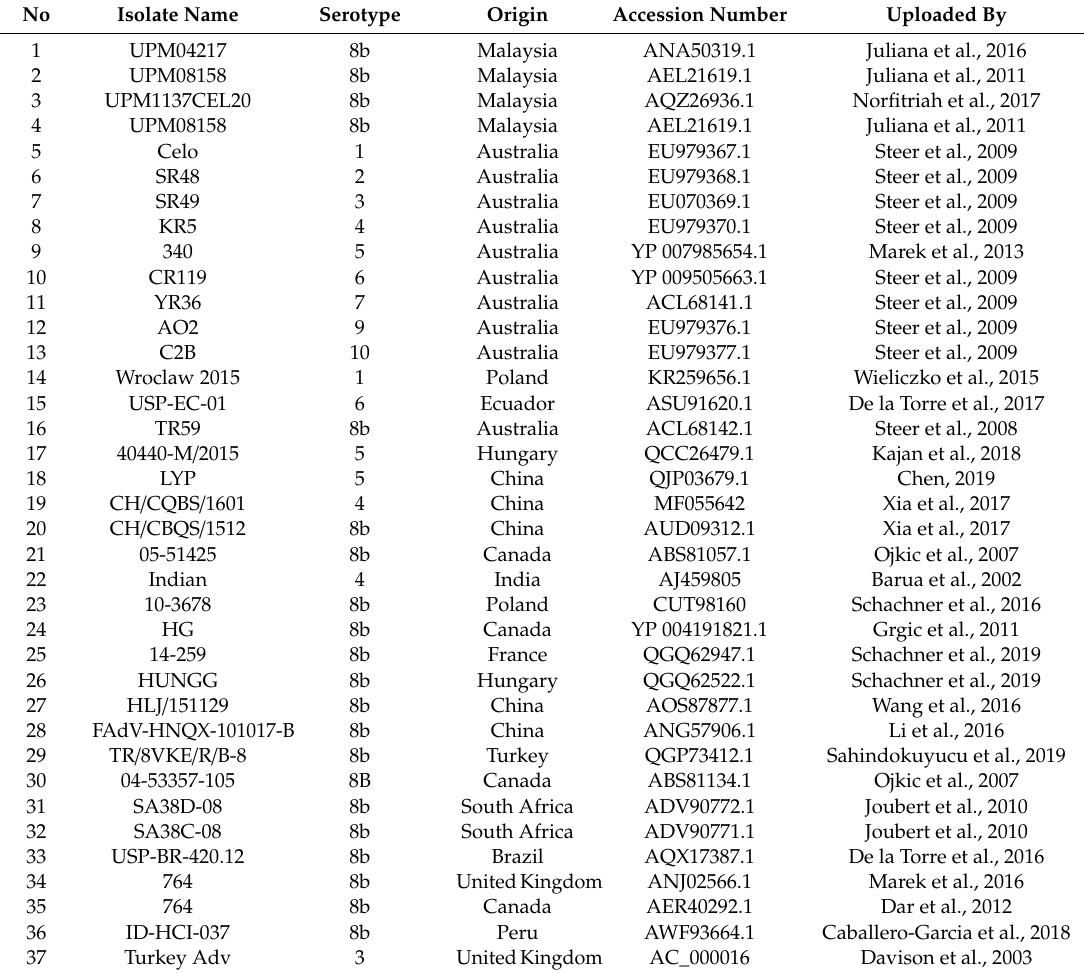
Table 2. The aviadenovirus reference strains obtained from Genebank used in the construction of phylogenetic tree for hexon gene